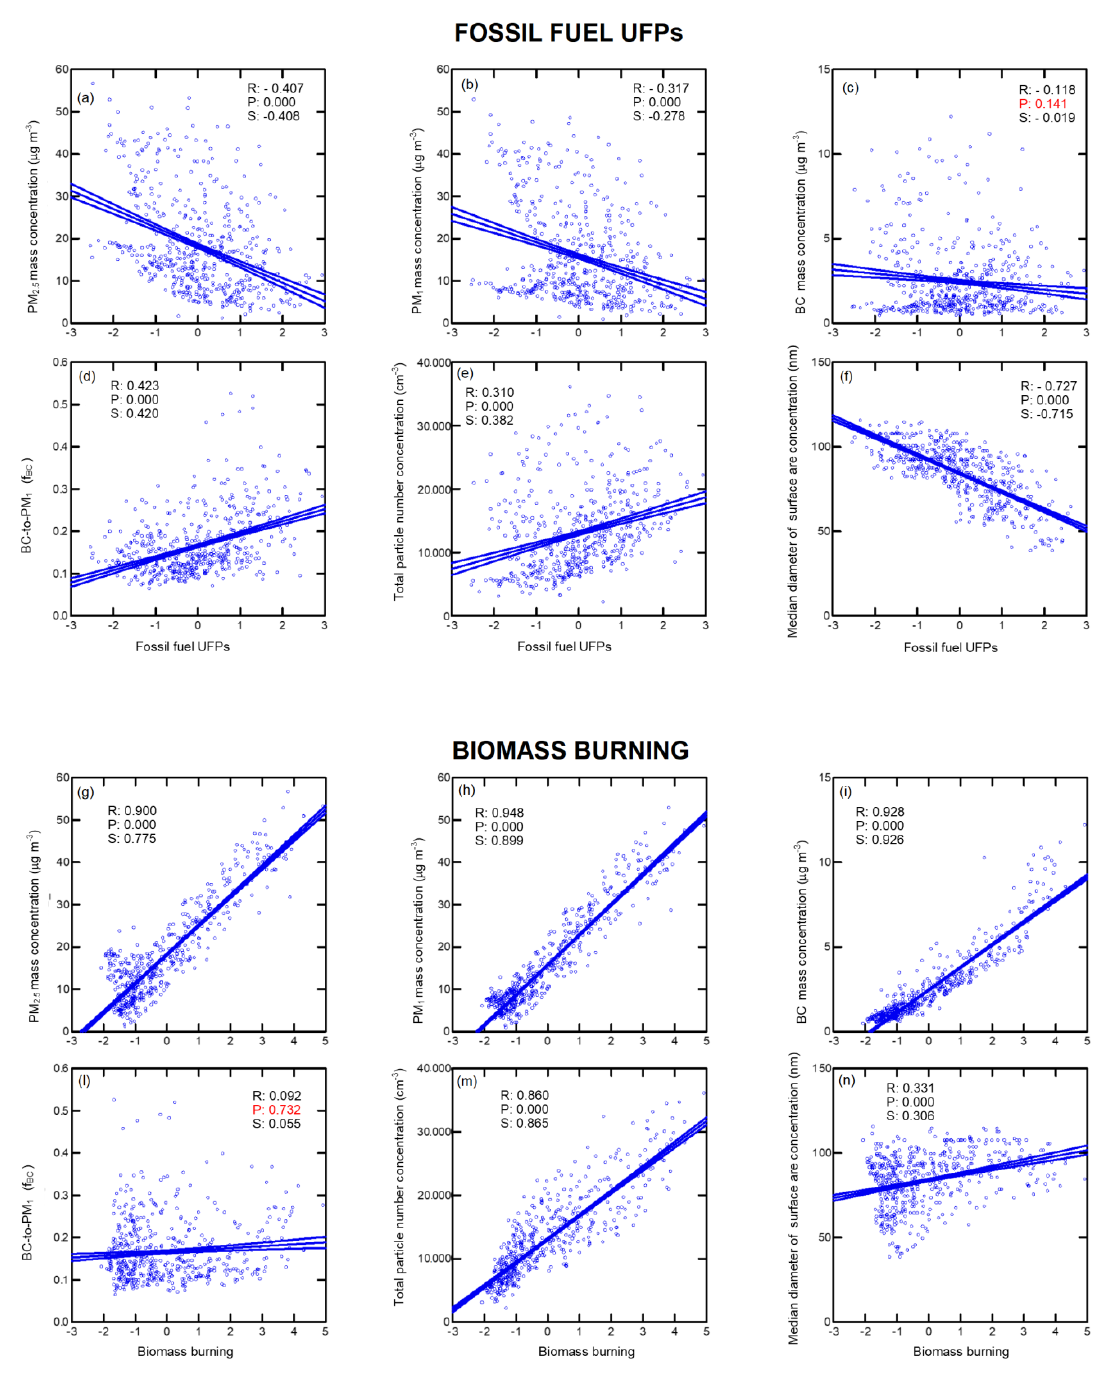
Figure 2. Regression lines between the two combustion derived aerosol types apportioned, fossil fuel UFPs (panels ( a) –( f) ) and biomass burning (panels ( g )–( n )), and the aerosol metrics, PM 2.5 , PM 1 mass concentration (panels ( a ), ( b ), ( g ) and ( h )), BC mass concentration (panels ( c ) and ( i )), BC-to-PM 1 mass fraction (panels ( d ) and ( l )), particle number concentration (panels ( e ) and ( m )), median particle diameter of the surface area size distribution (panels ( f ) and ( n )). Each panel shows the Pearson correlation coefficient(R), the Bonferroni probability (P), and the Spearman correlation coefficient (S). The number of cases is 529; the confidence interval of the regression lines is 0.5; data time resolution is 1 h.